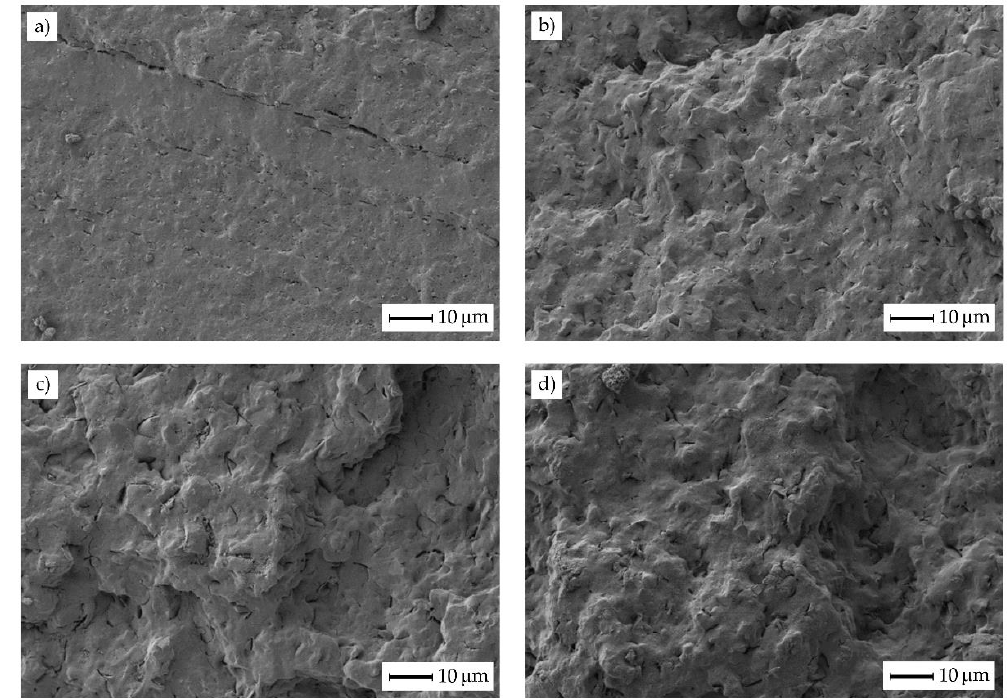
Figure 6. Field emission scanning electron microscopy (FESEM) images at 1000 × of the impact fracture surface morphologies of PHBH/PCL binary blends, subjected to PCL selective extraction, with different PCL wt%, ( a ) 10, ( b ) 20, ( c ) 30, and ( d ) 40.